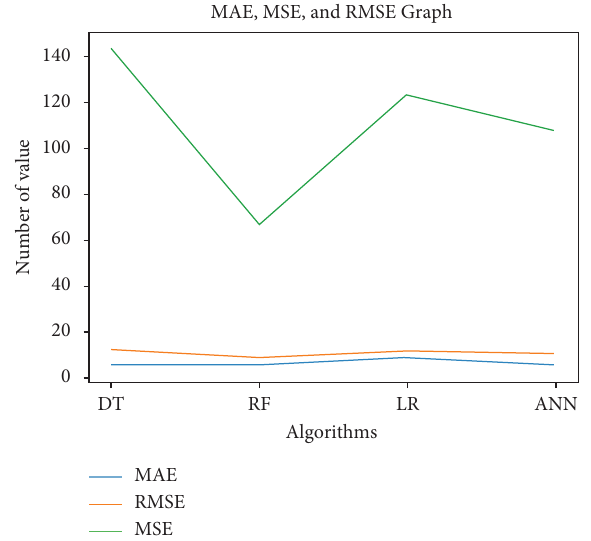
Figure 7: Comparisons of MAE, MSE, and RMSE of the algorithms.